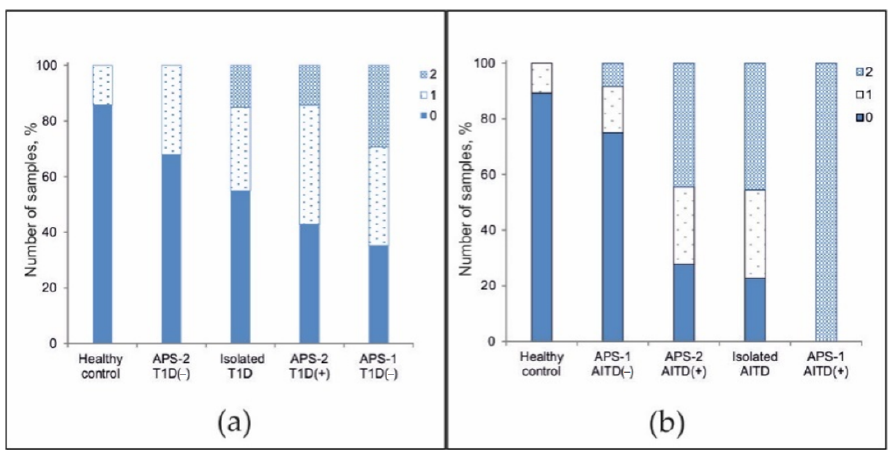
Figure 5. Frequency of positivity for organ-specific autoantibodies against ( a ) GAD-65, IA2, and ICA and against ( b ) TG and TPO among healthy controls and patients with APS-associated or isolated diseases. Designations: '+'—confirmed disease; '-'—absence of disease. At least one of two autoantibodies (TG or TPO) was detected in 10.7% of healthy patients ( n = 28), 16.7% of APS-1 patients without AITDs ( n = 12), 27.7% of APS-2 patients with a diagnosis of AITD ( n = 36), and 31.8% of patients with isolated AITD ( n = 22) (Figure 5b). In addition, two autoantibodies were detected in 8.3% of APS-1 patients who did not have AITDs, in almost half of APS-2 patients with a diagnosis of AITD (44.4%) or with isolated AITD (45.5%), and in all APS-1 patients with a diagnosis of AITD ( n = 6). Only three APS-2 patients had no AITDs, though all three had autoantibodies against both TPO and TG (data not shown). 3. Discussion In this study, a microarray-based multiplex assay was proposed for simultaneous detection of both organ-specific (anti-21-OH, anti-GAD-65, anti-IA2, anti-ICA, anti-Tg, and anti-TPO) and cytokine-specific (anti-IFN- ω , anti-IFN- α -2a, and anti-IL-22) autoan- tibodies that can be major biomarkers of autoimmune polyglandular syndromes. It is generally accepted that almost all APS-1 patients exhibit antibody reactivity to IFN- α and/or IFN- ω subtypes. However, these autoantibodies are also typical for patients with myasthenia gravis and thymoma [29]. Additionally, autoantibodies against type I inter- ferons can be detected in patients with systemic lupus erythematosus (up to 10%), Sjogren’s syndrome (up to 8.7%), rheumatoid arthritis (up to 2%) [30], and incontinentia pigmenti [31]. The results of our study show that the proportion of people with autoantibodies against cytokines among patients without diagnosed APS-1 is small (1.6%, 3/188). Moreover, similar to Meloni et al. early [12], we found no anti-cytokine autoantibodies in a group of patients with non-APS-1 polyendocrine autoimmunity, whereas another study reported the opposite finding [32]. Although we did not assess the neutralizing ability of the identified autoantibodies against IFN- ω , IFN- α -2a and IL-22, the results obtained allowed us to correctly identify 18/18 patients with APS-1. Moreover, the de- tection of a characteristic signature of three autoantibodies (anti-IFN- ω + anti-IFN- α -2a + anti-IL-22) in a patient via this microarray allows the identification of patients with APS-1 with 100% specificity. However, the questions of whether this three-autoantibody sig-